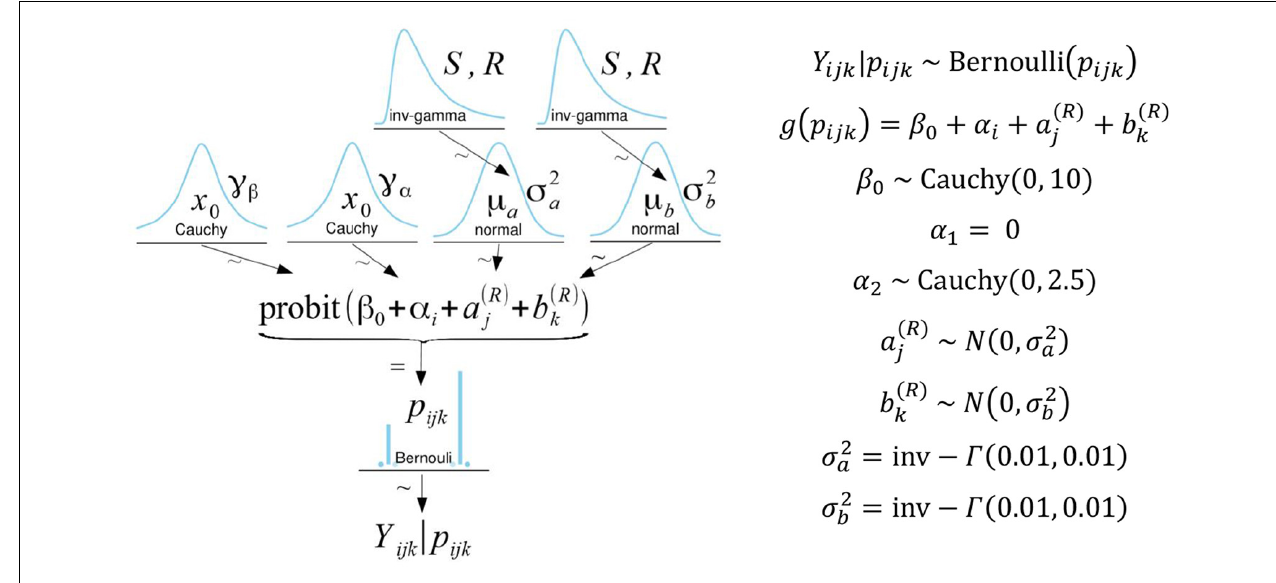
FIGURE 5 | On the left is a diagram illustrating the model, priors, and hyperpriors used in the analysis. Specific model parameters are listed on the right. α 1 is set to zero as a constraint for model identification such that α 1 reflects the baseline condition (HIM). Therefore, α 2 represents the effect of the DIM relative to the HIM (Song et al., 2017). In the model, the subscripts i, j, and k refer to the interface, target, and participant,